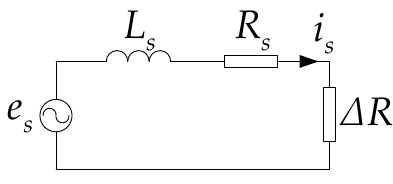
Figure 4. Equivalent circuit of coils inter-turn short circuit.